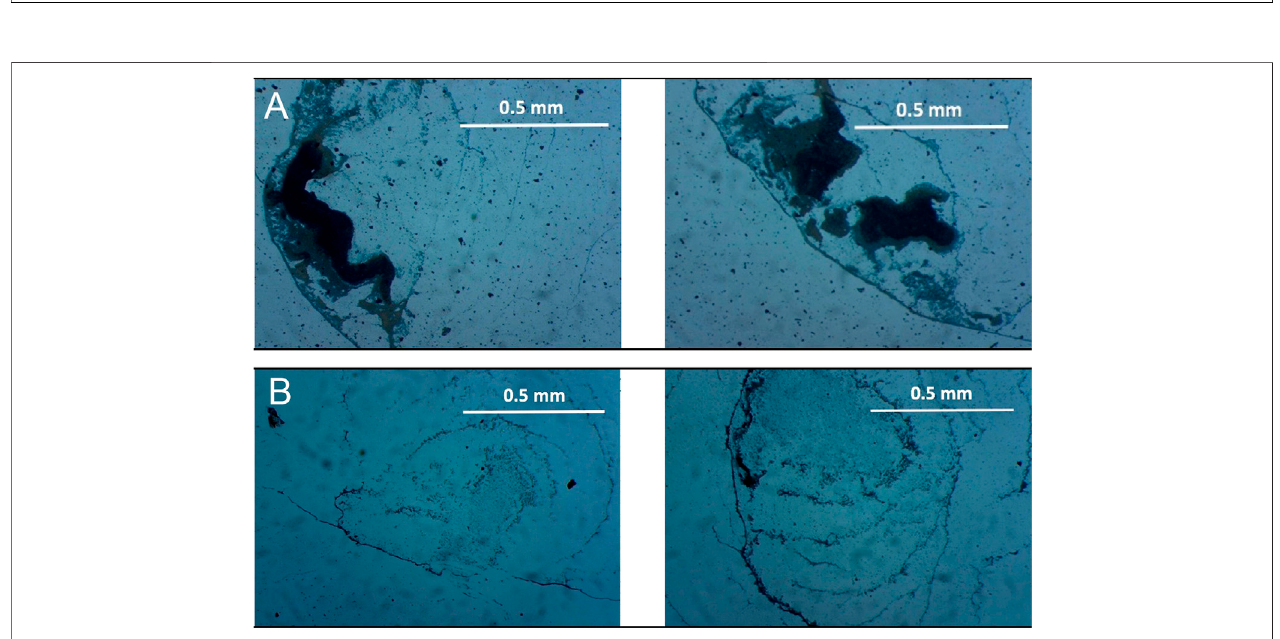
FIGURE10| Examplesofphotosofthedistributionofmicrospheresindrieddropletsin1 × 10 – 19 MHyFndilution(upperrow, (A) )andofmicrospheredistributionin dried water “ dilutions ” drops, corresponding to a dilution of 1 × 10 – 19 M (lower row, (B) ). Here accumulation of microspheres is also observed, but it differs from dense accumulations in droplets with 1 × 10 – 19 M HyFn (A) . Only 5 drops out of 36 have structures similar to those shown in (A) .